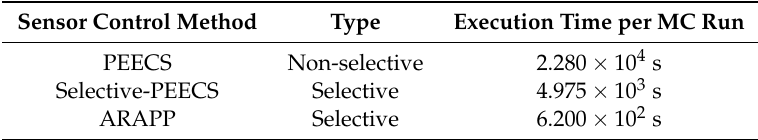
Table 3. Comparison of computational speed achieved by recent sensor control methods as reported in